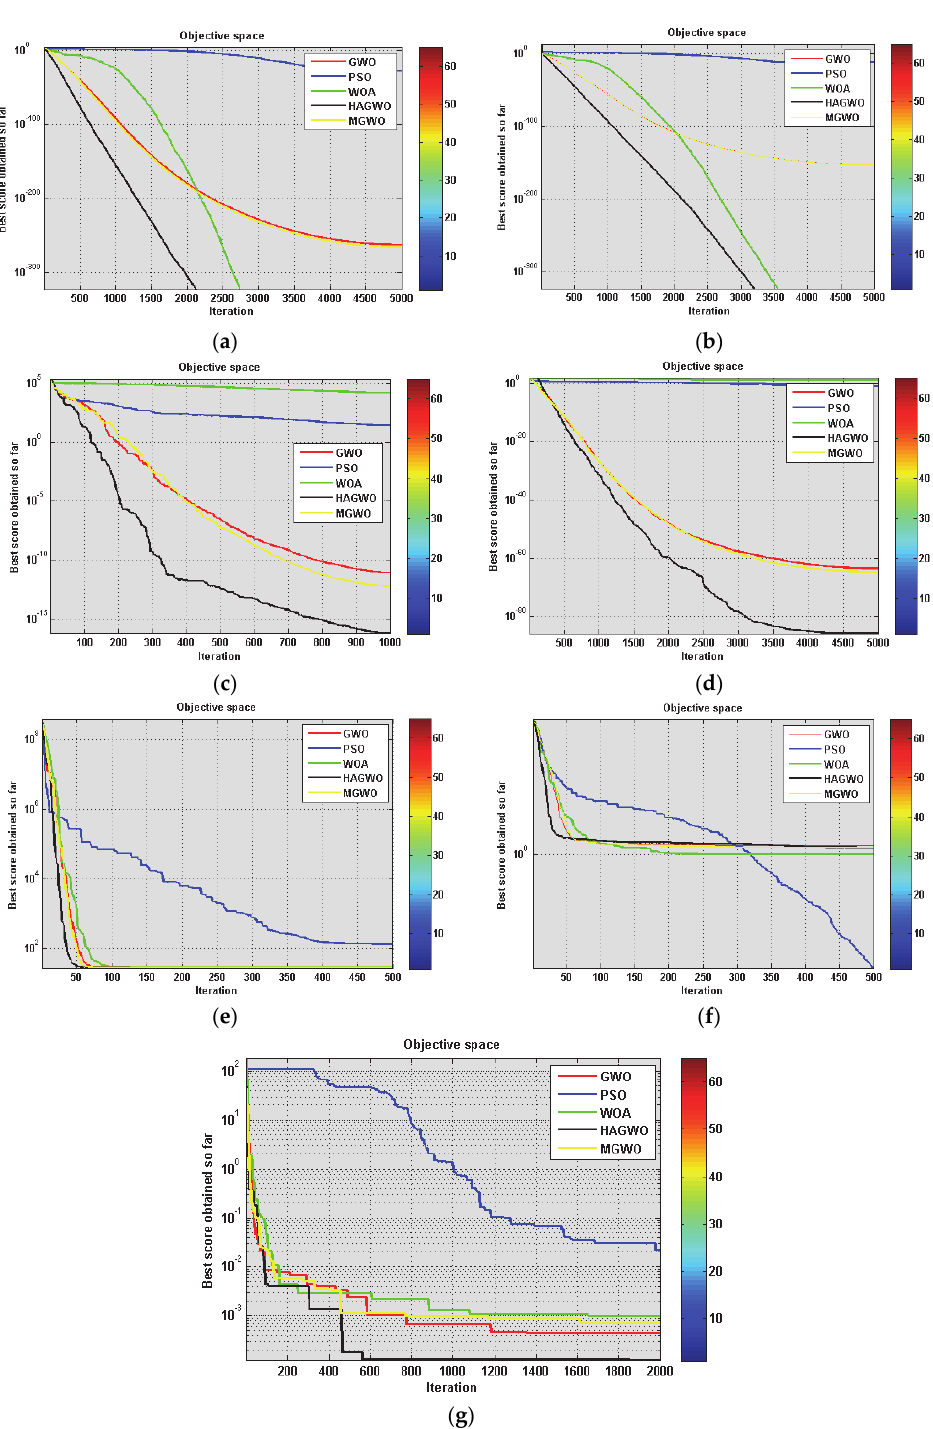
Figure 2. Convergence Curve of PSO, GWO, WOA, MGWO and HAGWO variants on Unimodal benchmark functions.